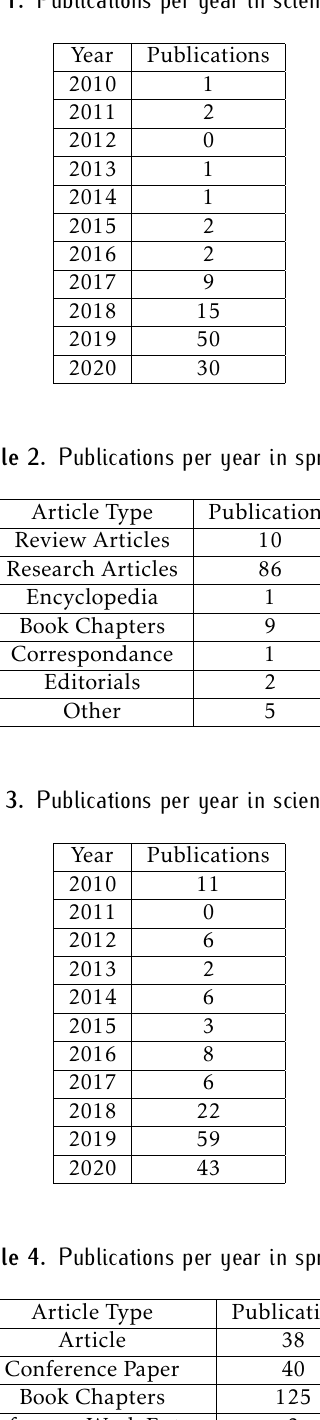
Table 1. Publications per year in sciencedirect